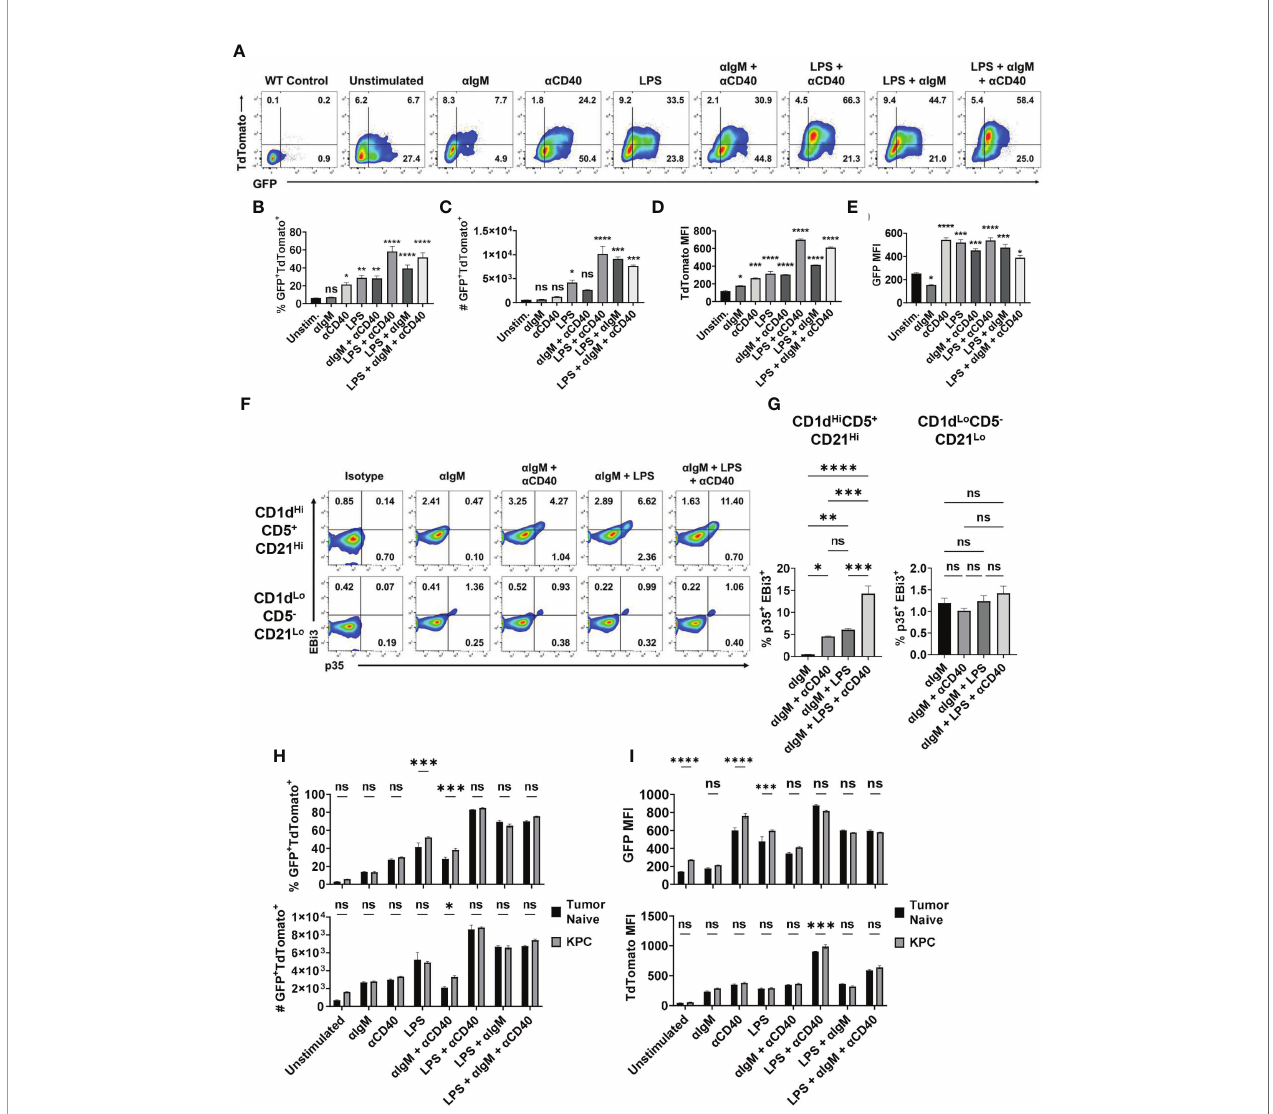
FIGURE 1 | Combined BCR/TLR signaling induces IL-35 expression in B cells. (A) Representative fl ow cytometry plots of splenic Il12a GFP/GFP ; Ebi3 Tom/Tom CD19 + CD21 Hi CD1d Hi CD5 + B cells after stimulation. (B) Frequency of GFP + TdTomato + B cells from (A) . N=3. (C) Number of GFP + TdTomato + B cells from (A) . N=3. (D) TdTomato mean fl uorescent intensity (MFI) in B cells from (A) . N=3. (E) GFP mean fl uorescent intensity (MFI) in B cells from (A) . N=3. (F) Representative fl ow cytometry plots of WT splenic CD19 + CD21 Hi CD1d Hi CD5 + (top) and CD19 + CD21 Lo CD1d Lo CD5 - (bottom) B cells intracellularly stained for p35 and EBi3 after stimulation. (G) Frequency of p35 + EBi3 + B cells from (F) . N=3. (H) Frequency (top) and number (bottom) of GFP + TdTomato + B cells from Il12a GFP/GFP ; Ebi3 Tom/Tom B cells derived from tumor-naïve and KPC4662 tumor-bearing mice after ex vivo stimulation. N=3. (I) TdTomato mean fl uorescent intensity (MFI) in B cells from (H) (top) and GFP MFI in B cells from (H) (bottom) after indicated ex vivo stimulation. N=3. Error bars indicate SEM. P values for 1B-E, G were calculated using one-way ANOVA. P values for 1H-I were calculated using two-way ANOVA. NS, non-signi fi cant, *p<0.05, **p<0.005, ***p<0.001, ****p<0.0001. Experiments were performed using 7 – 8-week-old mice of indicated genotypes. Experiments were repeated 3